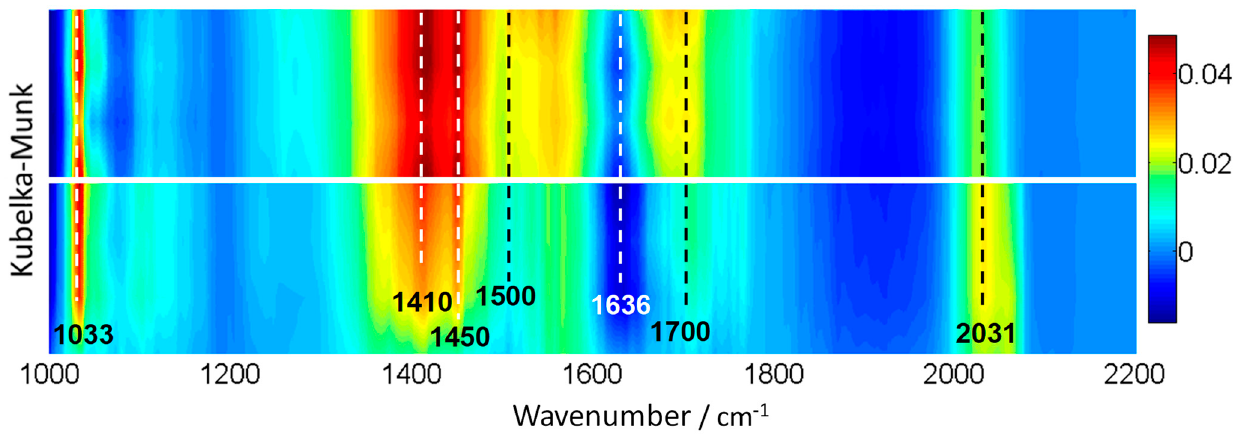
Figure 4. Difference infrared spectra of the T sample using a 30/70 methanol/water reaction mixture under dark ( bottom panel ) and illumination ( upper panel ).